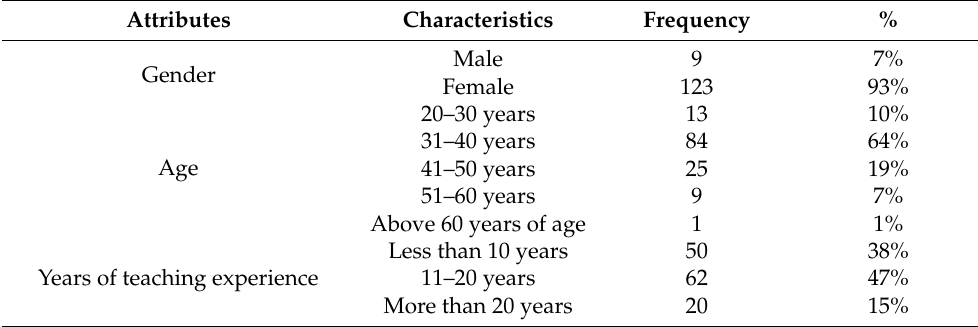
Table 2. Demographic information of